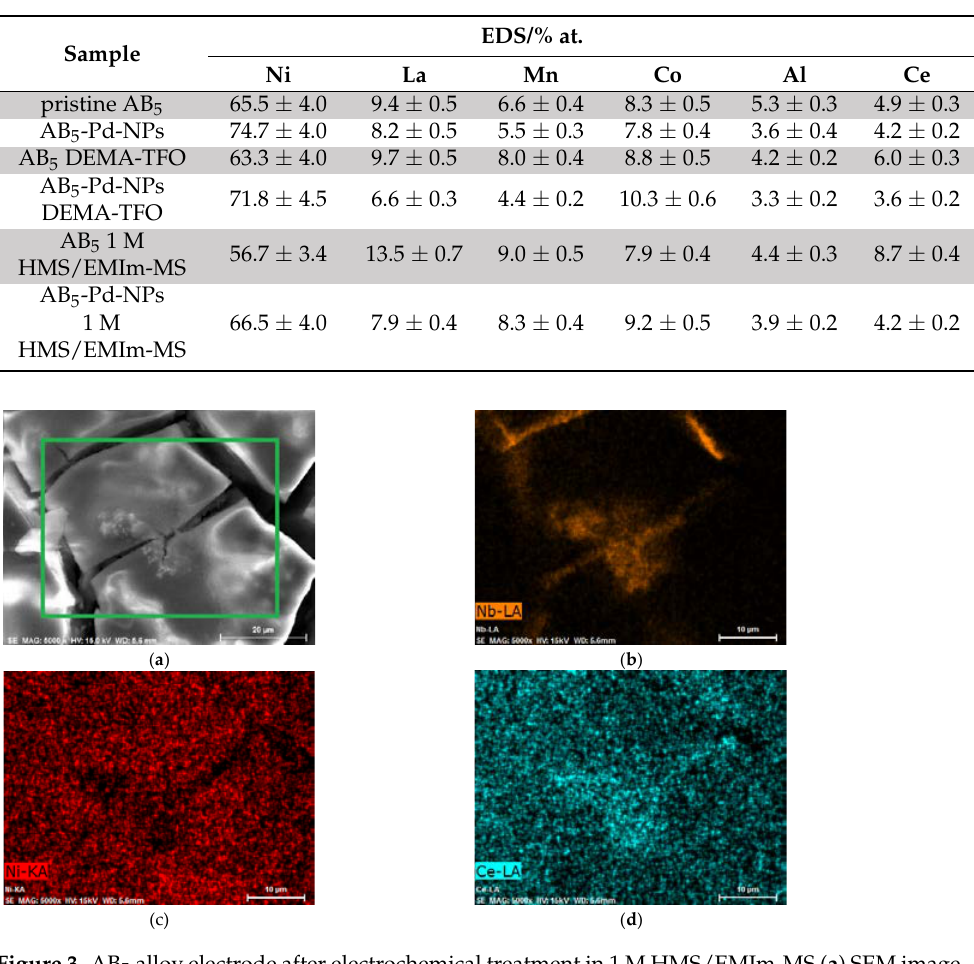
Table 2. Atomic concentrations (EDS) for AB 5 and AB 5 -Pd-NPs electrodes before and after electro- chemical treatment in DEMA-TFO and 1 M HMS/EMIm-MS.